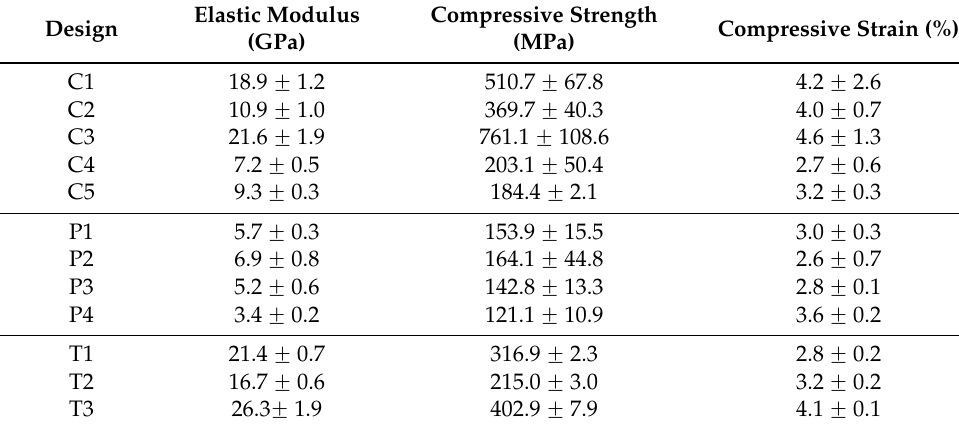
Table 2. Results from mechanical testing ( n = 5 for each